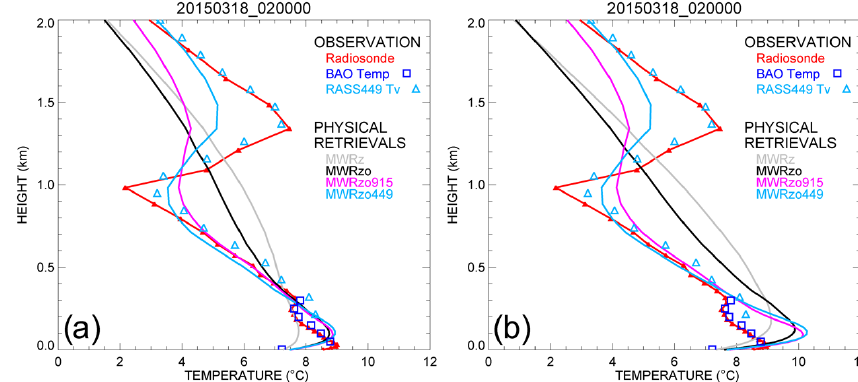
Figure 5. As in Fig. 2 but for 18 March 2015 at 02:00UTC. The RASS 449 virtual temperature is included as light blue triangles. Panels (a) shows the PRs obtained after applying the radiosonde BC, and (b) shows the PRs obtained after applying the TROPoe BC on the MWR T b s.